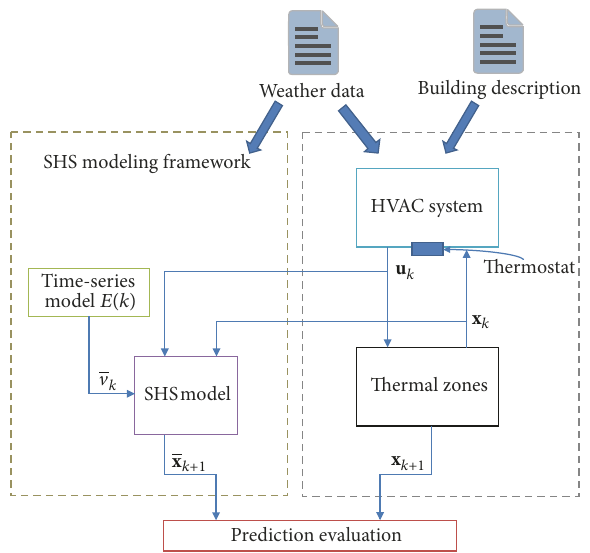
Figure 3: Block diagram of the experiment setup.